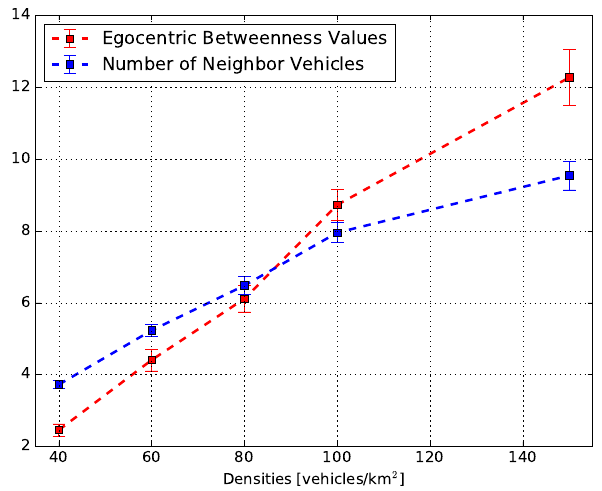
Figure 10. The relationship between the egocentric betweenness score and the number of one-hop